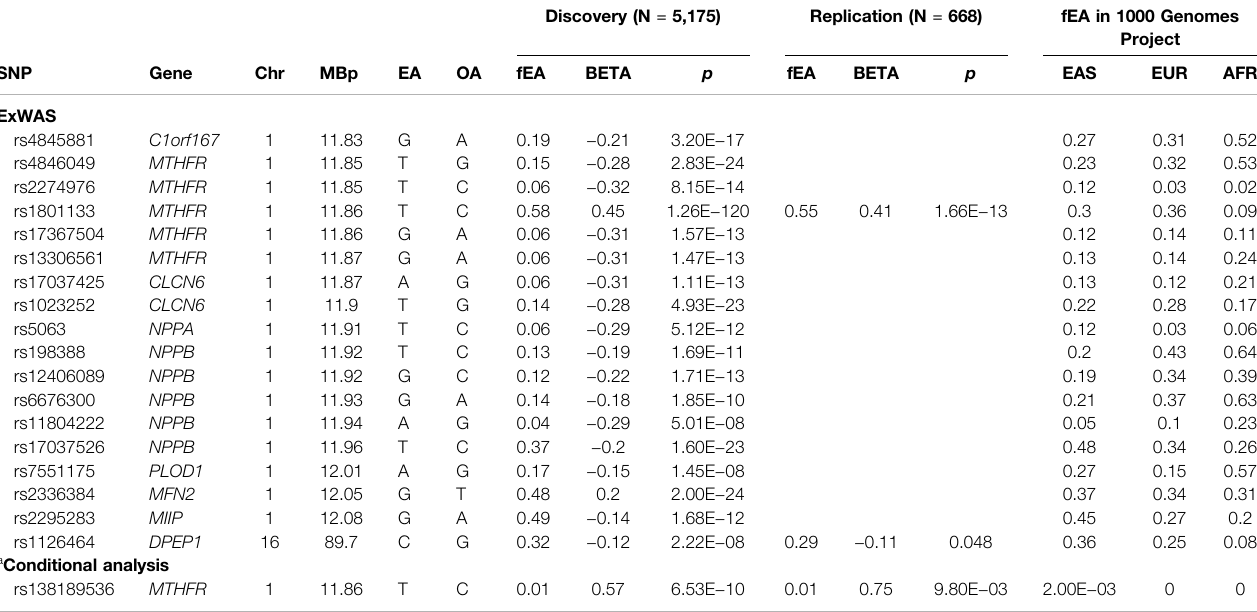
TABLE 1 | Exome-wide signi fi cant variants associated with tHCY levels from ExWAS.